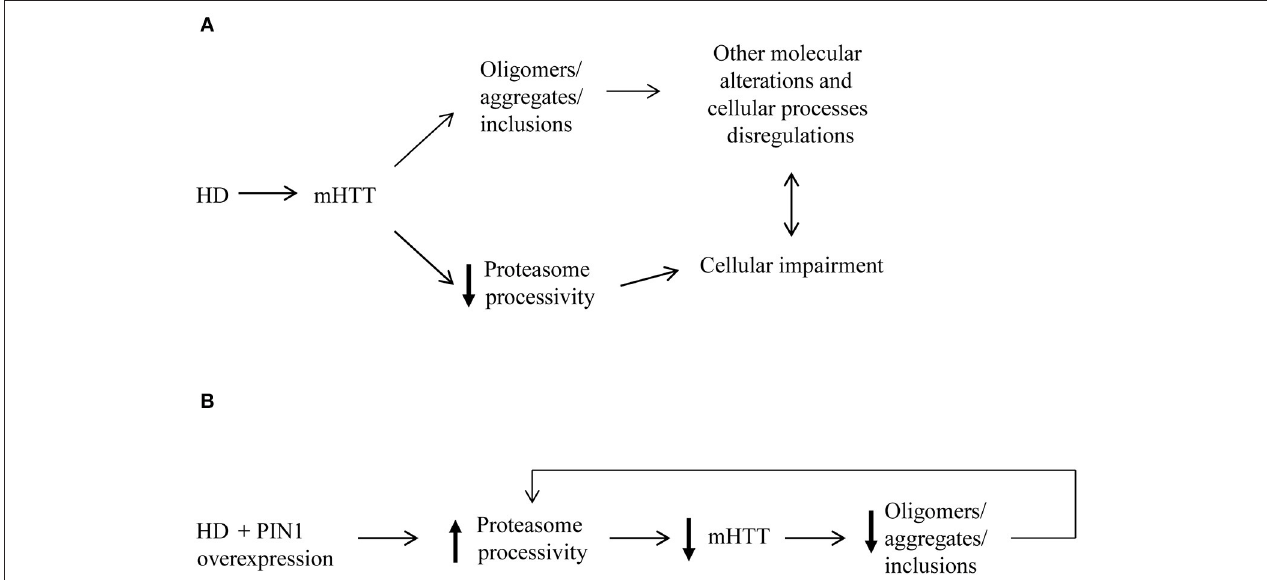
FIGURE 7 | Proposed model for mHTT aggregate reduction induced by PIN1. (A) The presence of mHTT aggregates as well as disruption in the protein flow through the proteasome contribute to several alterations of many cellular processes in HD. (B) Our data suggest that the overexpression of PIN1 could stimulate proteasome activity leading to an increased degradation mHTT N-terminal fragments. Increased mHTT clearance results in reduced levels of mHTT protein and, as a consequence of this, of mHTT aggregate load. This might create a feedback loop that release some of the pressure on the proteasome as well as other cellular mechanisms targeted by mHTT that could potentially lead to a slowdown of the degenerative processes.